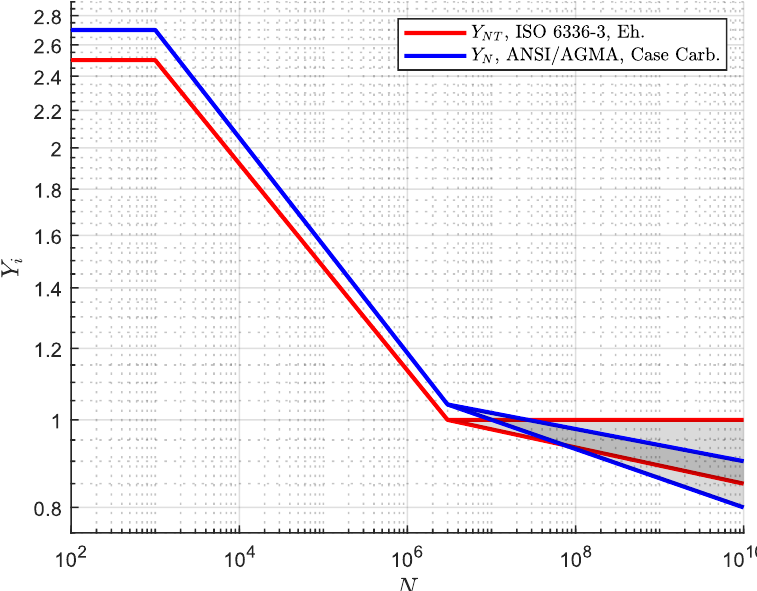
Figure 1. Typical shape of gear SN curve according to ISO 6336-3 [6] and ANSI AGMA 2001-D04 [7] considering tooth root bending for case-hardened gears.